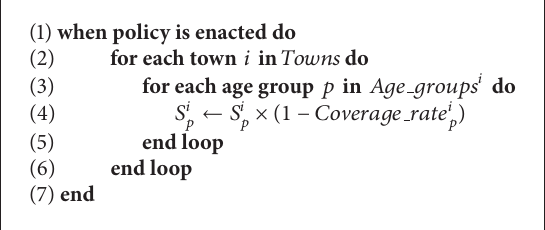
Pseudocode 1: Vaccinating randomly chosen individuals (parame- ters list: Towns, Age groups, Coverage rate